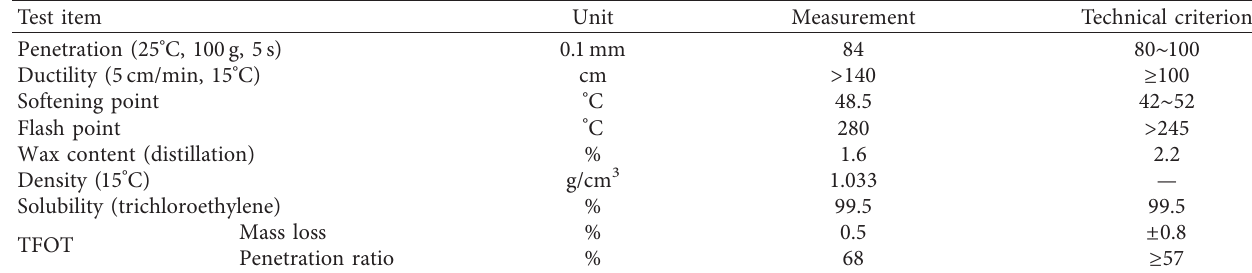
Table 2: Apparent density and water absorption of aggregate.